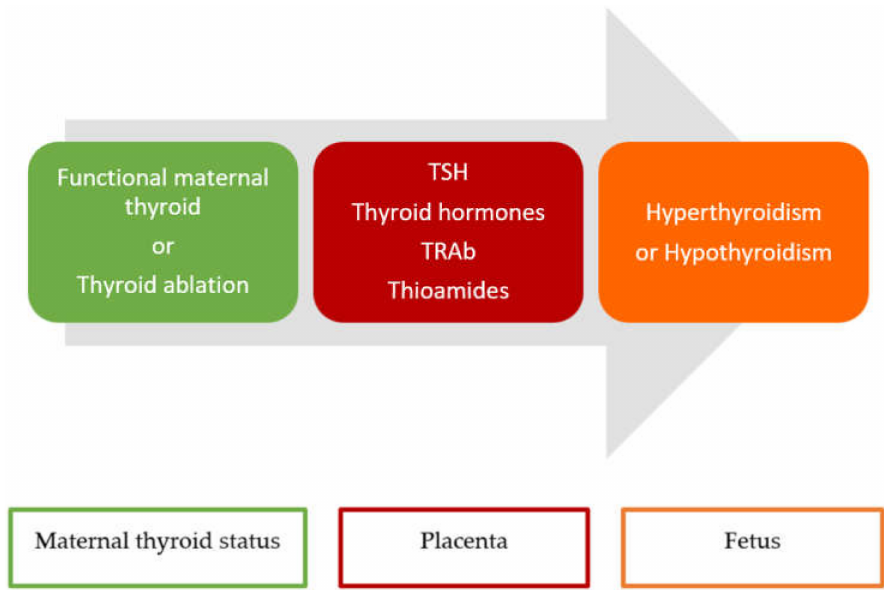
Figure 5. Transplacental passage of maternal hormones, medication and antibodies during preg- nancy in women with or without thyroidectomy; TSH = thyroid stimulating hormone; TRAb = TSH receptor